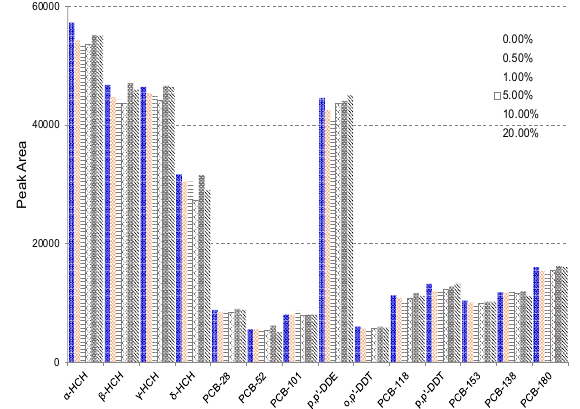
Fig. 5. Effects of salt addition on the extraction efficiency.